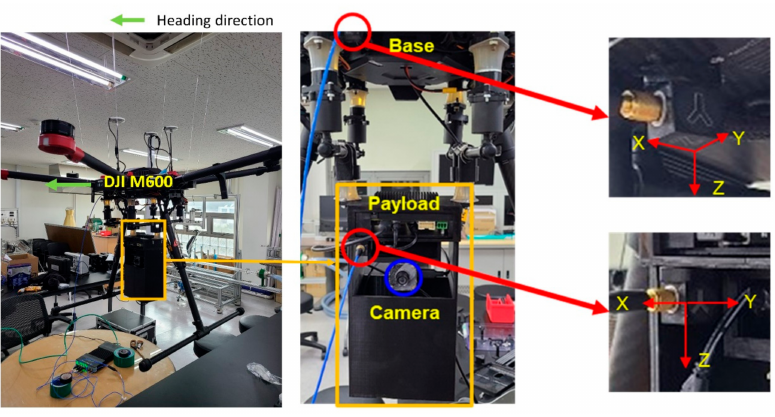
Figure 2. Experimental set-up for the transmissibility